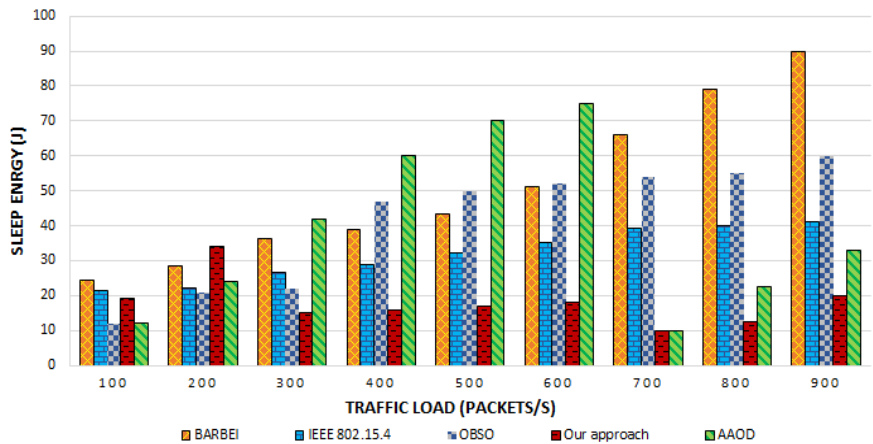
Figure 11. Reception energy consumption.